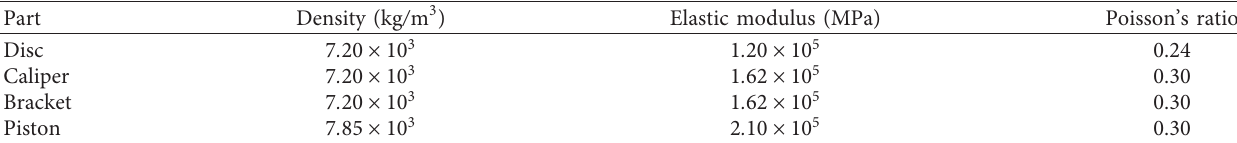
Figure 2: Finite element model of the brake. Table 1: Material parameters of main parts.